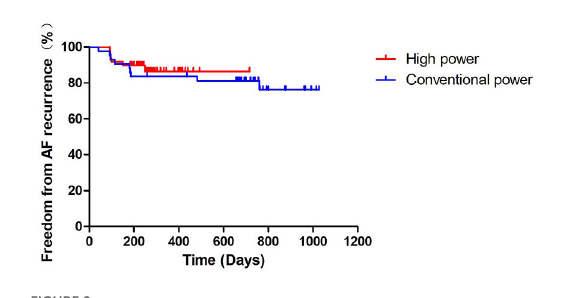
FIGURE2 Kaplan-Meier curve of freedom from AF recurrence. AF, atrial